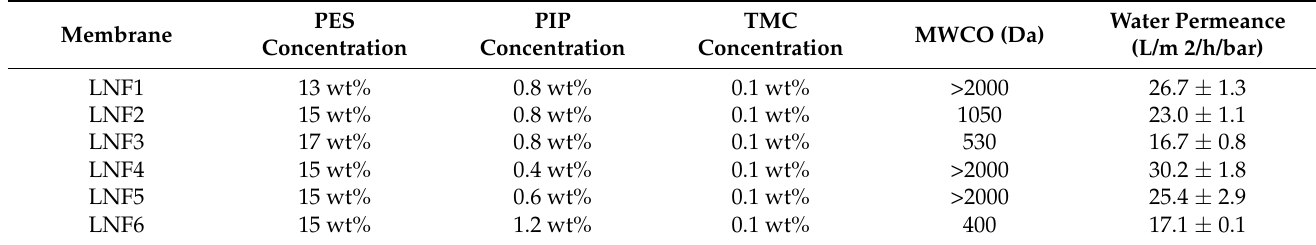
Figure 1. Schematic procedure of preparing LNF membranes by the NIPS–IP method. A total of six TFC membranes were synthesized by varying the PES and PIP weight concentrations in the casting solution in the ranges of 13–17% and 0.4–1.2%, respectively (Table 1). At least two replicates were prepared for each membrane. The membranes were characterized for the surface and cross-section morphologies by using atomic force mi- croscopy (AFM, Dimension ICON, Bruker, Germany) and field emission scanning electron microscopy (FESEM, Hitachi S5500, Japan). Table 1. The preparation conditions and characteristics of the six LNF membranes.